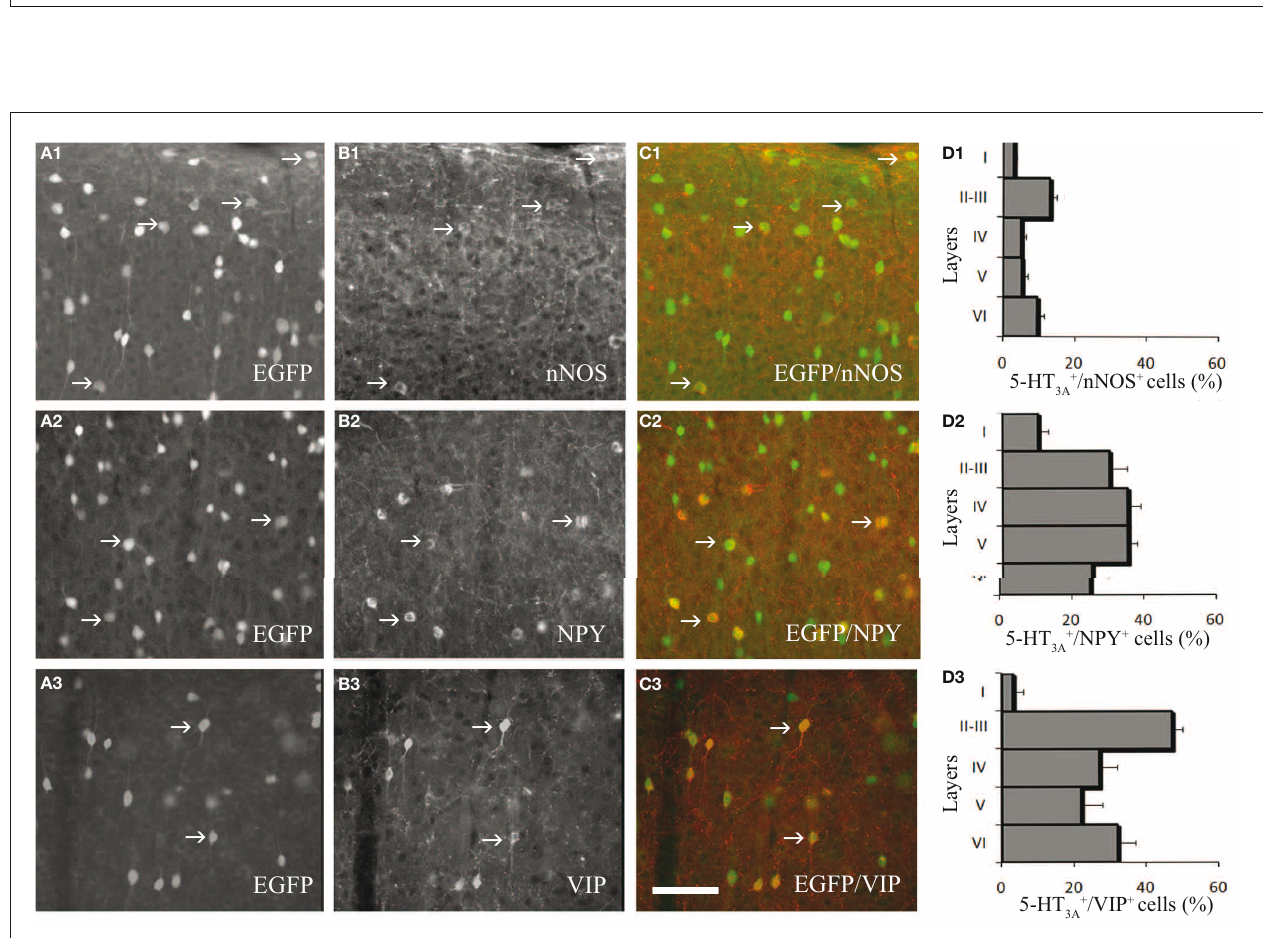
layers. (C) Density of 5-HT 3A -expressing cells from transgenic 5-HT 3A :GFP mice in the different layers of the primary somatosensory cortex. Scale bar: 250 μ m.